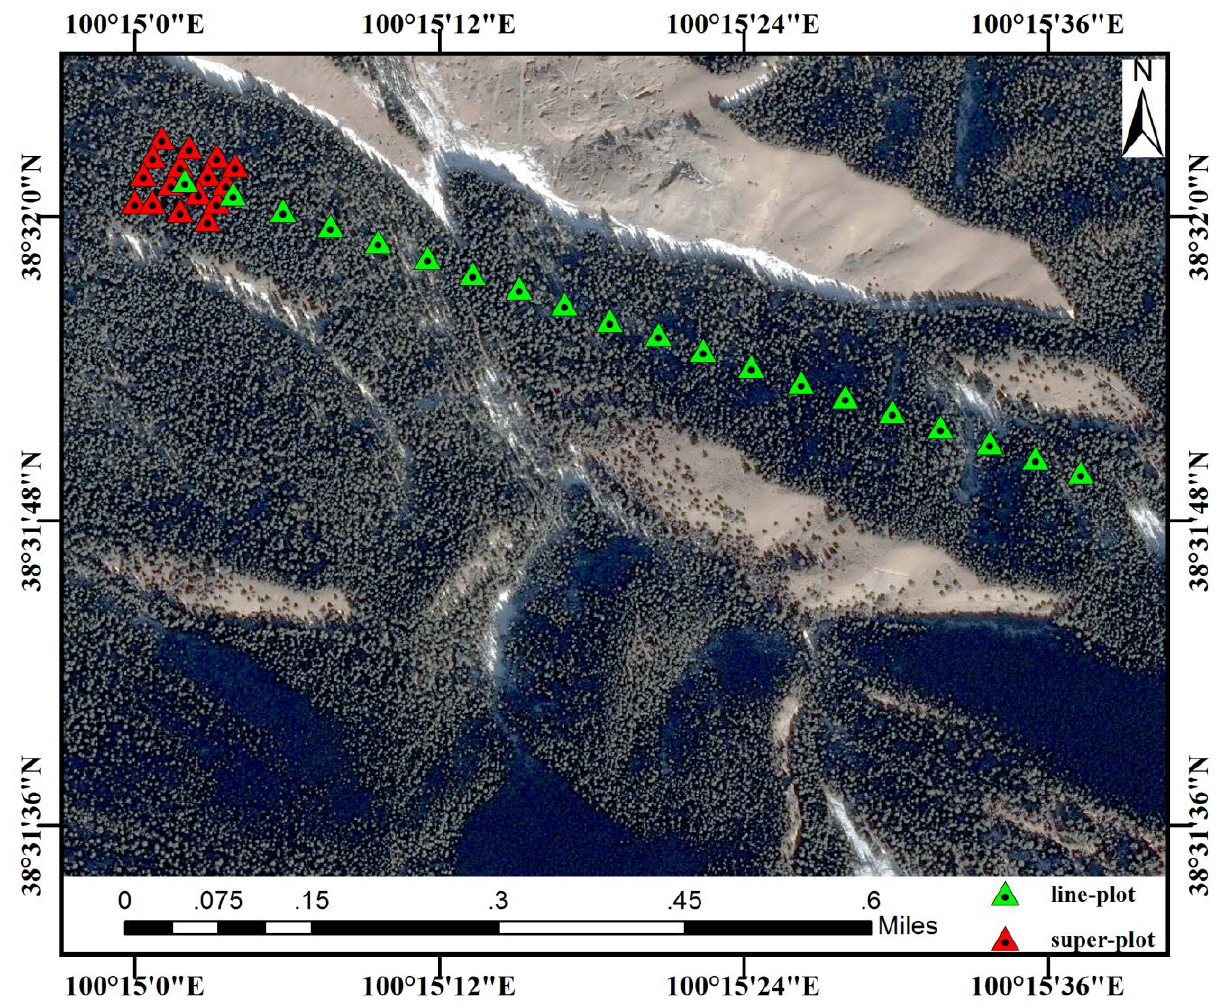
Figure 1. The study area and distribution of sampling sites (black points “.” are the center of field plots) accuracy of the normalized vegetation point is not taken into